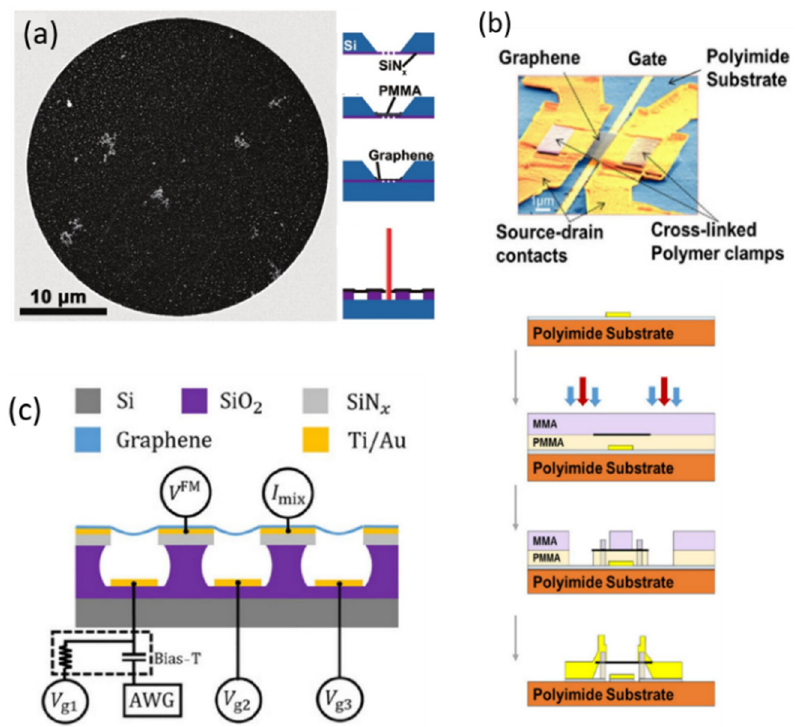
Figure 1. Fabrication of graphene resonators. ( a ) Transfer the CVD graphene to suspended nitride film with prefabricated holes [13]. ( b )Transfer the methyl methacrylate (MMA) film with graphene to the polymethyl methacrylate (PMMA)-covered substrate followed by non-etching suspension process [14]. ( c ) Simultaneous deposition of source-drain electrodes and local gate electrodes after etching [10].